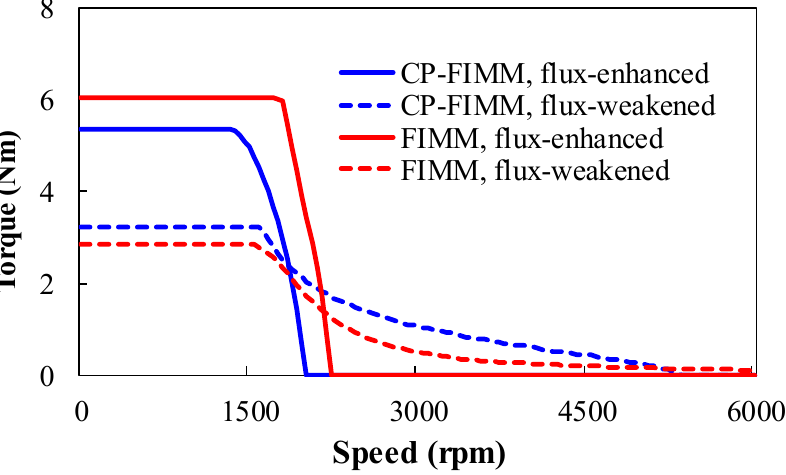
Figure 14. Torque-speed waveforms of the CP-FIMM and FIMM under different MSs.